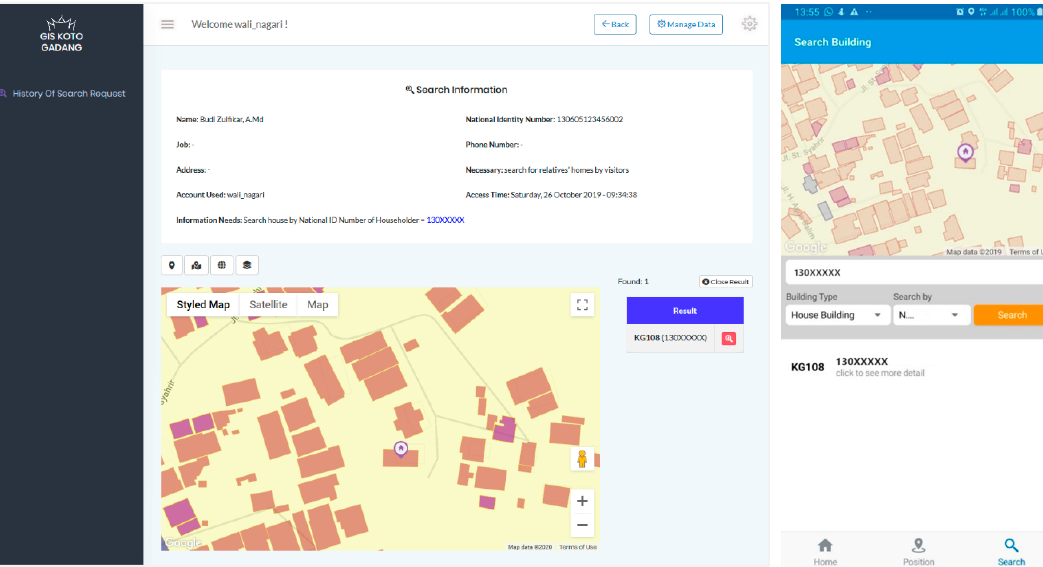
Figure 14. The search results for residents’ houses based on the owners’ tribes in Sikumbang.